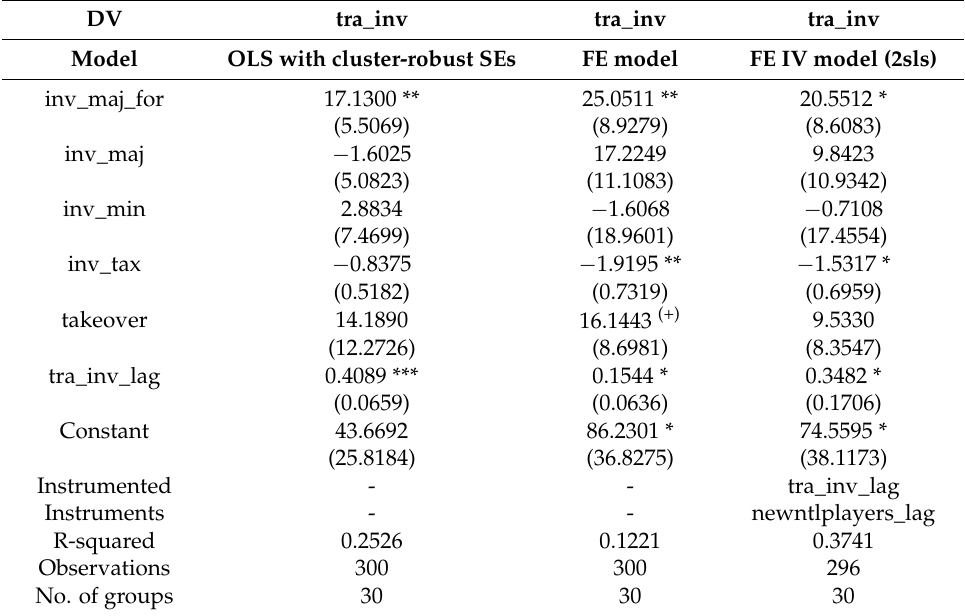
Table 10. Key regression results: team